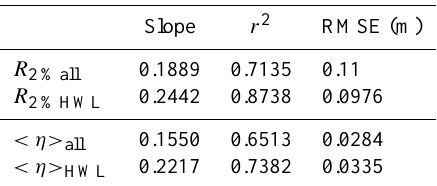
Table 2. Zero intercept linear regression to R 2% values with respect to (SH s L 0 ) 1 / 2 and < η > values with respect to β f (H 0 L 0 ) 1 / 2 , con- sidering the whole set of data and those associated with high water level (HWL) ( Z ≥ Z 5% = 0.32m), correlation ( r 2 ), and root mean square error (RMSE) in